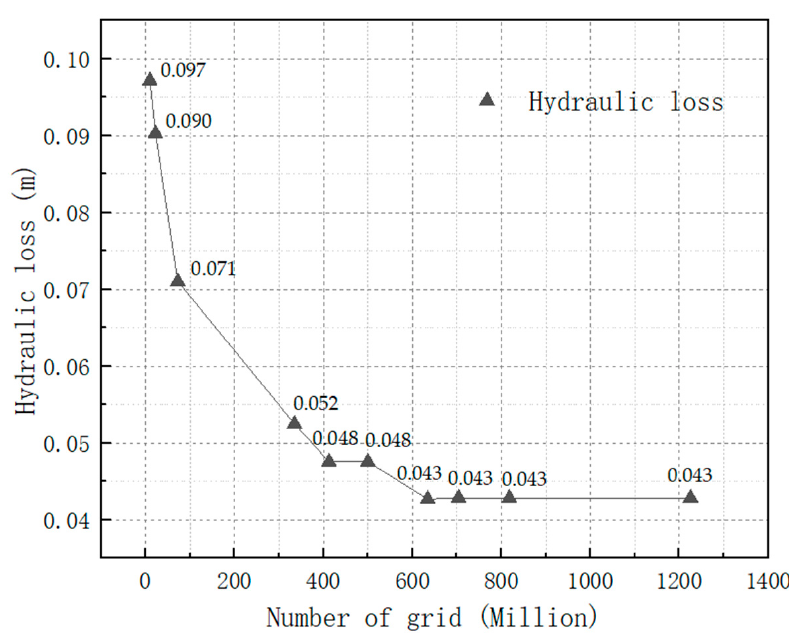
Figure 4. Hydraulic loss diagrams under different grid schemes.